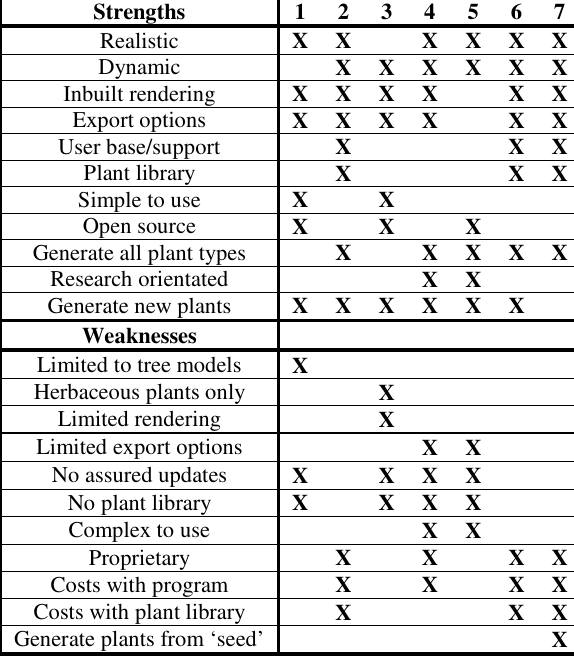
Table 1. Strengths and weaknesses analysis table.